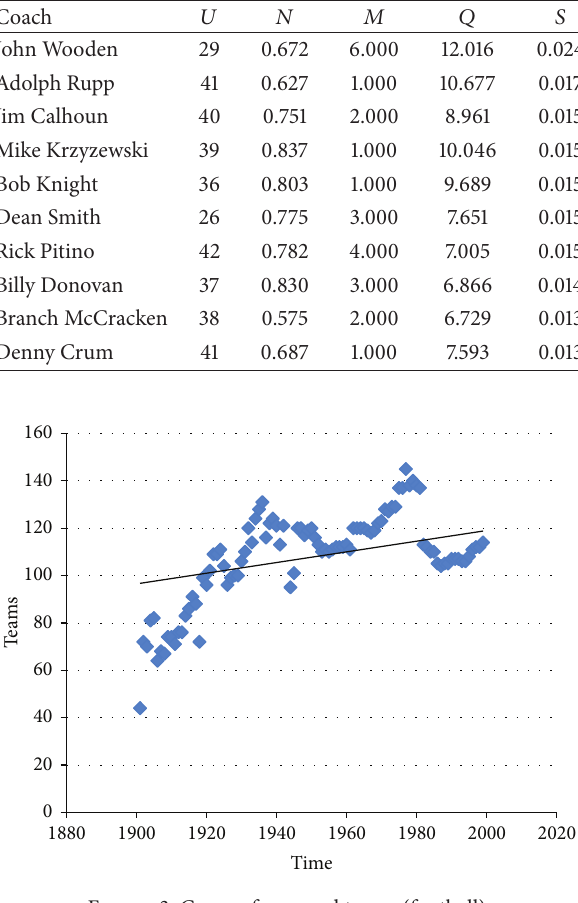
Figure 3: Curve of year and teams